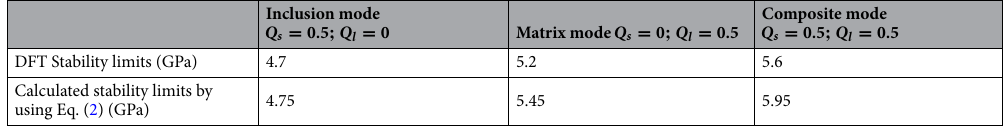
Table 4. Comparison between DFT simulations and mixture model (Eq. (2)) with 50% occupancy in three representative modes.